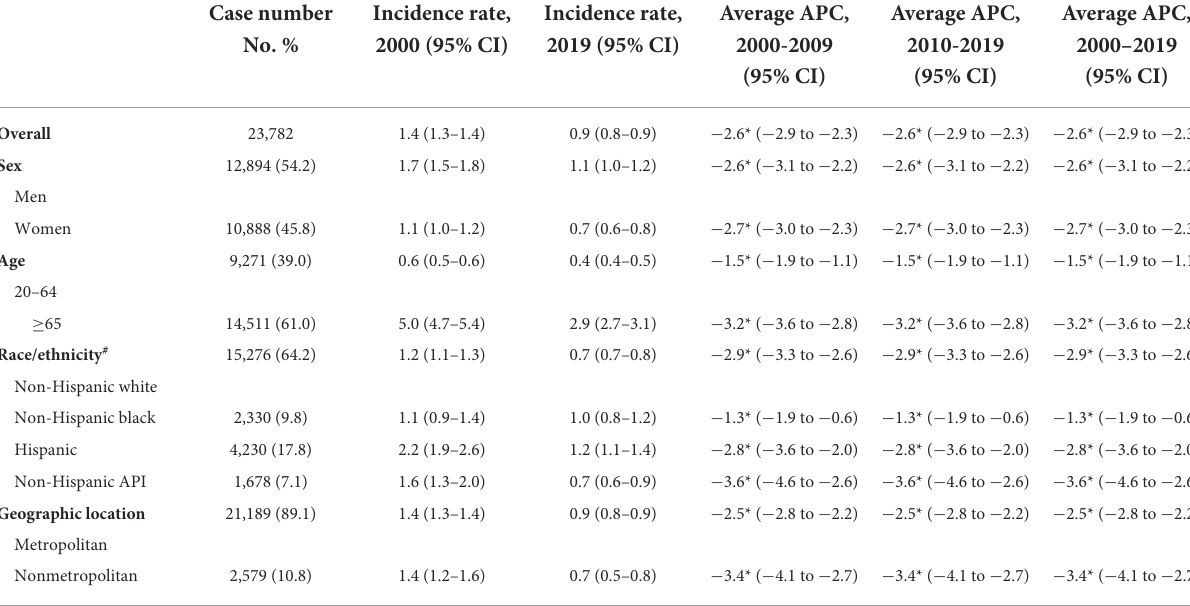
TABLE 3 Incidence rate and trend in gastric non-Hodgkin lymphoma among US adults aged ≥ 20, 2000–2019. Case number Incidence rate, Incidence rate, No. % 2000 (95% CI) 2019 (95%